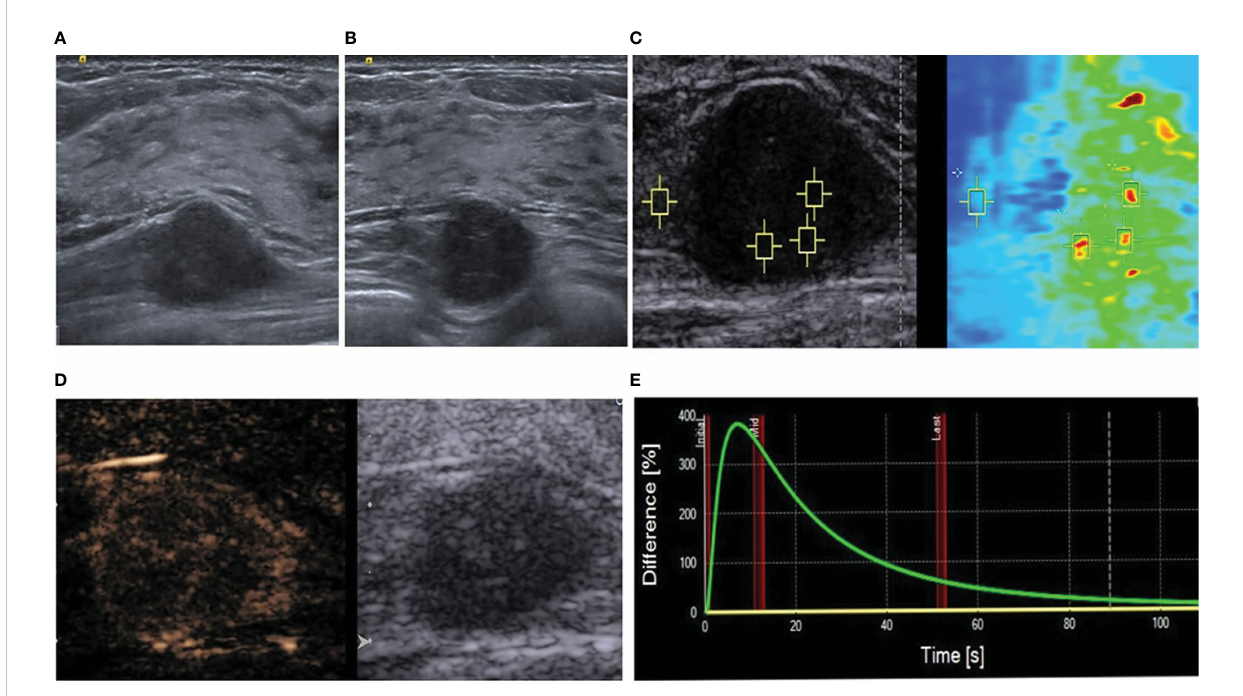
FIGURE 1 Multimodal ultrasonographic assessment of the mass. (A) Long-axis ultrasound showing a hypoechoic mass located deep in the pectoralis major muscle; it was deep in the gland and the upper right breast. (B) The adjacent glands appear blurred. (C) Virtual touch tissue imaging and quanti fi cation mode. The depth is 2.4 cm, median speed 6.06 m/s, and mean speed 6.18 m/s. The surrounding muscular layer is 2.72 m/s. (D) Qualitative contrast-enhanced ultrasound results. (E) Time-intensity